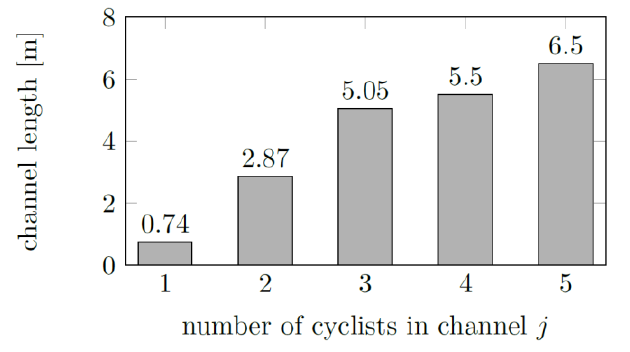
Figure 7. Channel length vs. number of cyclists (channel size)